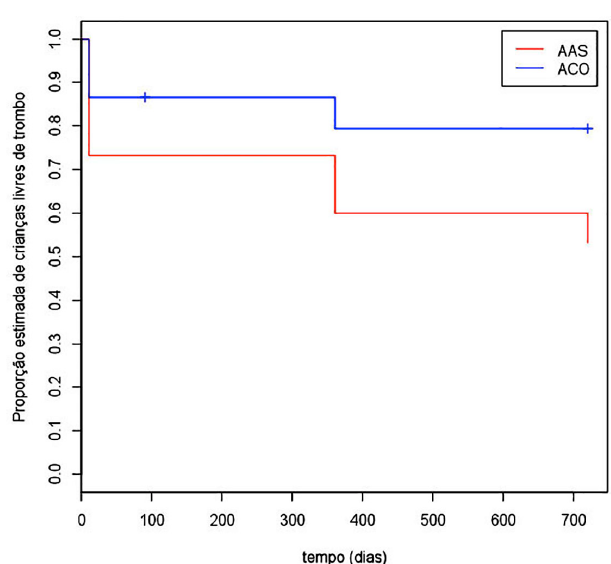
Fig.1 - Thrombus-free survival curve comparing the ASA group to the OAC group.